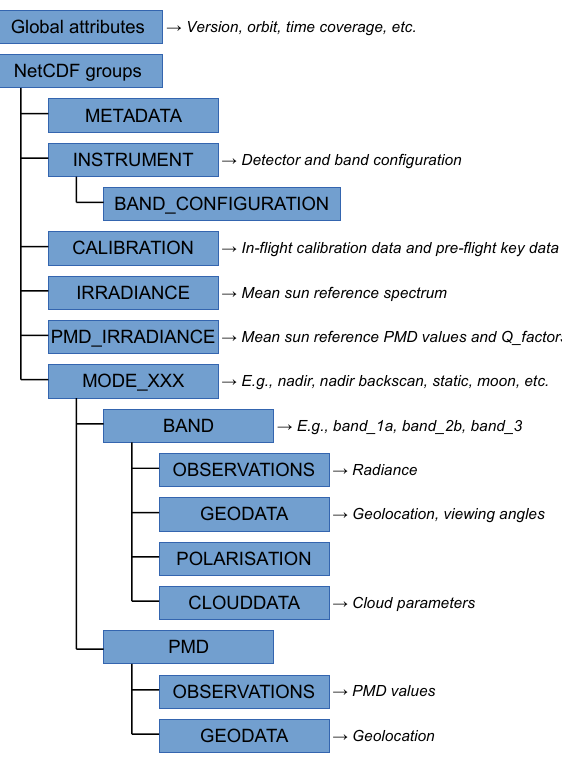
Figure A1. NetCDF structure of new GOME level 1 file generated with GDP-L1 version 5.1. Measurements are organised in groups for different modes and bands (see text for more